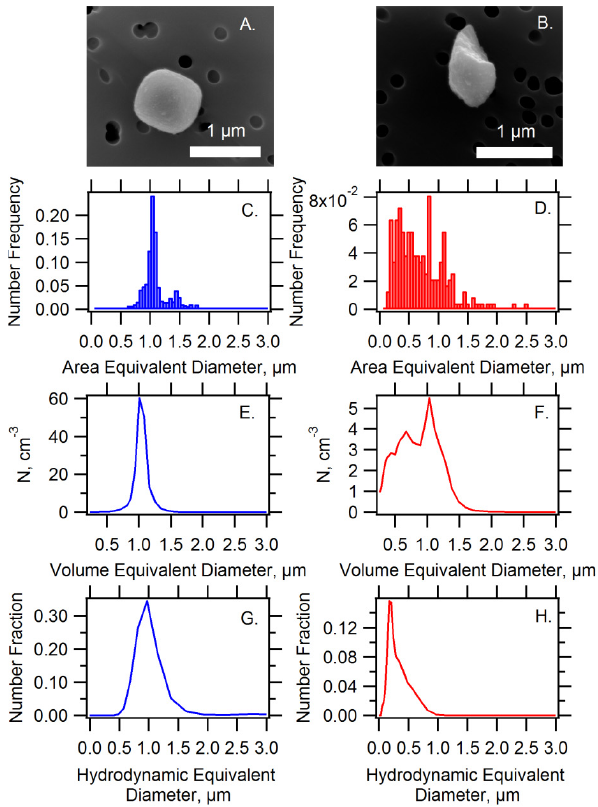
Fig. 1. SEM images of (A) a cubic hematite particle and (B) a milled hematite particle. Number frequencies estimated by SEM for each subset of hematite particles are shown in (C) and (D) . Particle size distributions measured in the AIDA chamber are shown in (E) and (F) . DLS measured size distributions are also shown in (G) and (H)